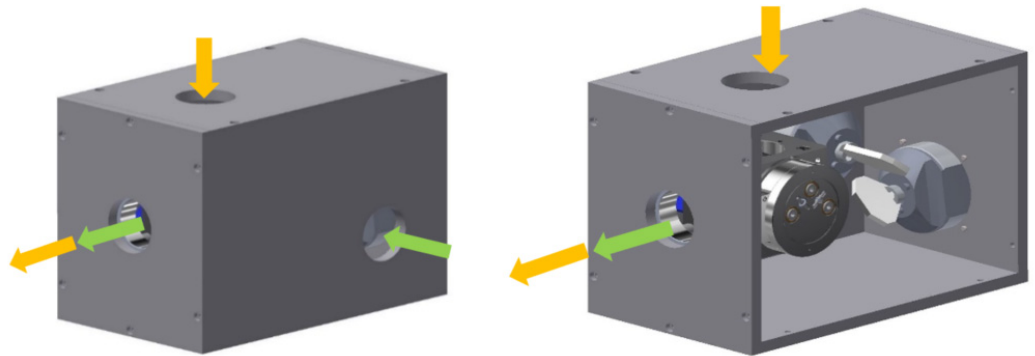
Figure 10. Integration unit for coupling the beam paths in the machine and for manipulating the measuring beam.